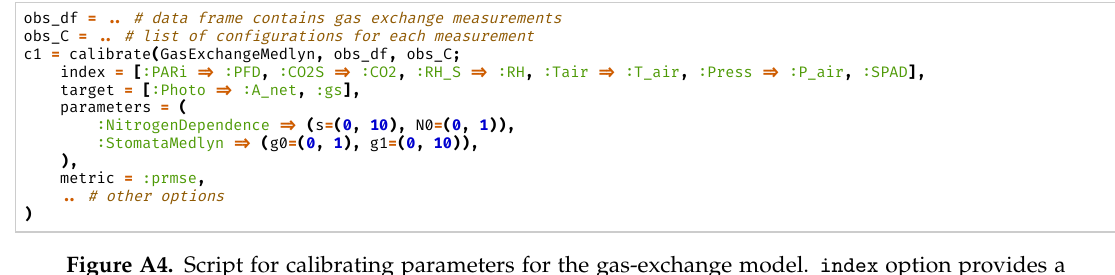
model with four levels of RH (RH) from 20 % to 80 % and plotting gs ( g s ) against Ci ( C i ) in lines (Figure A5). Each line of response was composed by changing CO2 ( C a ) in a range from 10 µbar to 1500 µbar at an interval of 10 µbar.